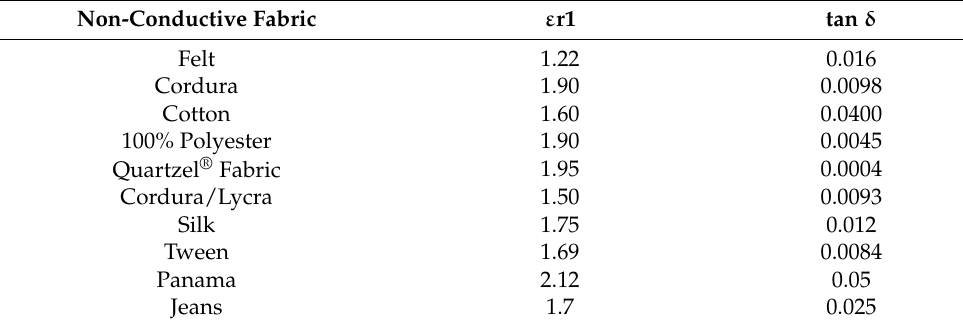
Table 1. The Dielectric Properties of Normal Textile Fabrics.